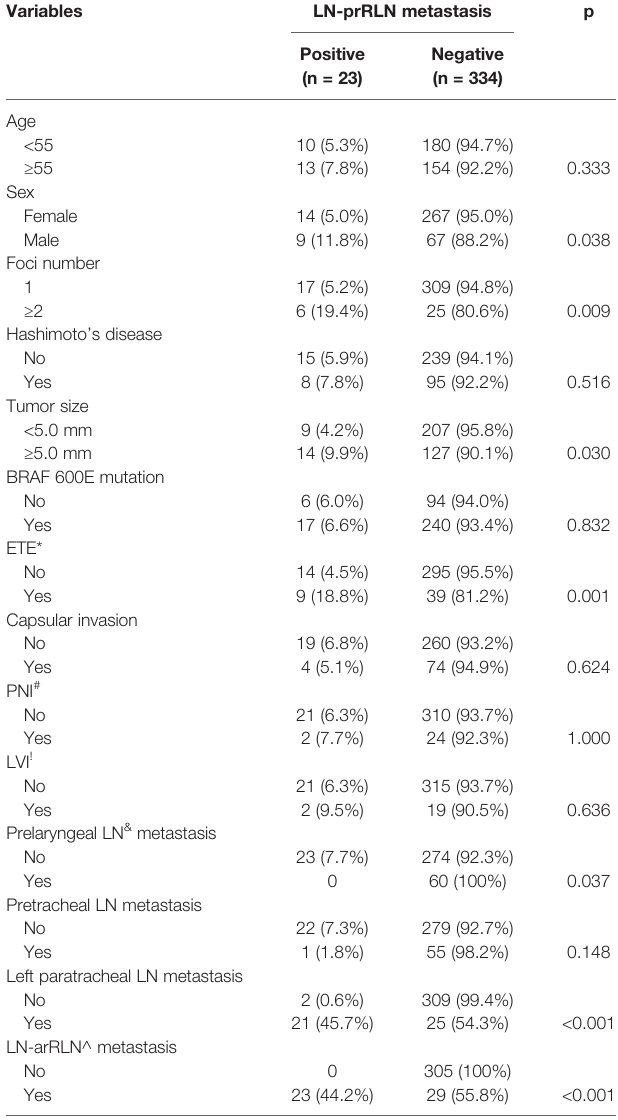
TABLE 2 | Univariate analysis of predictor for lymph node posterior to the right recurrent nerve metastasis